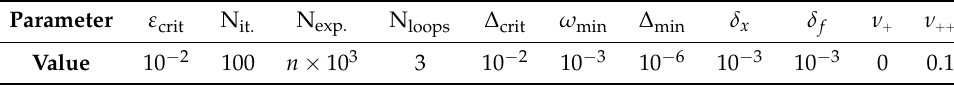
Table 3. Parameters for Figure 3, radii relative to [ 0,1 ] n .